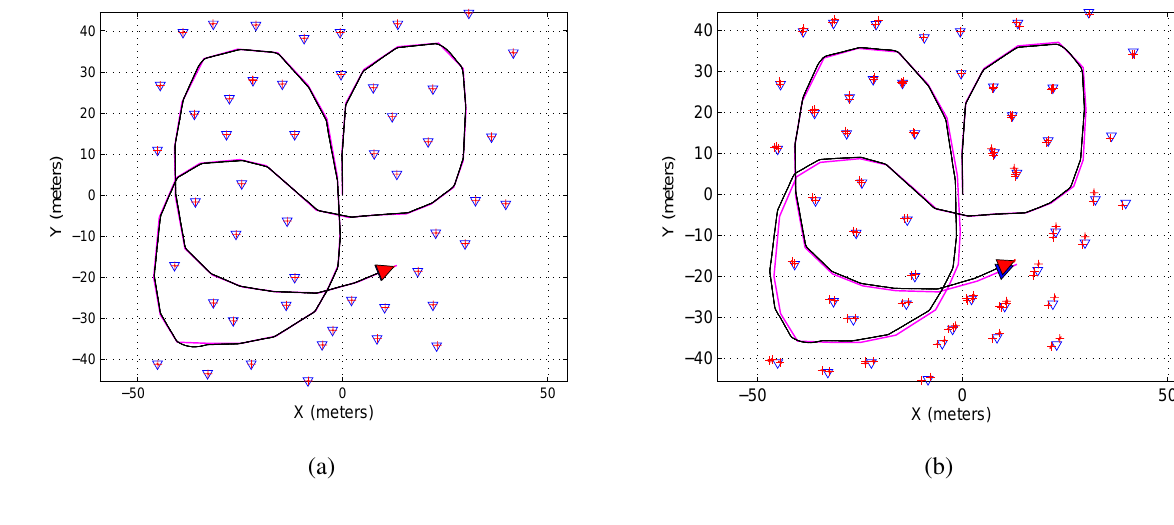
Figure 9. Map reconstruction of the environment using the features’ covariance selection criterion on the EKF-SLAM. (a) Shows the map reconstruction when the five most significant features— LIM = 5 in Algorithm 5—were used for the correction stage of the EKF-SLAM; (b) shows the map reconstruction when LIM = 2 . The path traveled by the mobile robot is represented in a solid black line and the path estimated by the SLAM in solid magenta; the features are represented by blue triangles and the ellipses of uncertainty associated with each feature are in solid